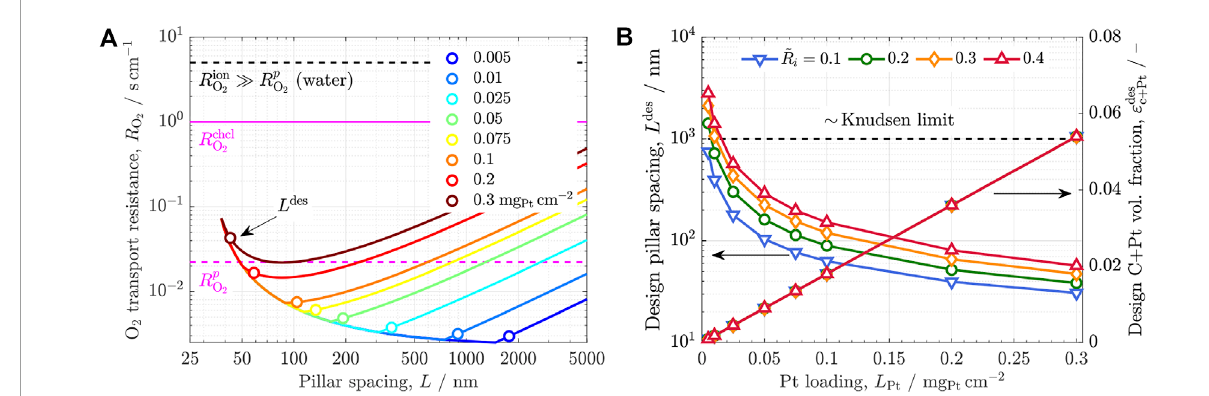
FIGURE 7 (A) Variation of the bulk O 2 transport resistance of the bi-functionalized bimodal cathode CL, R cl O , with the pillar spacing, L , corresponding to 2 various Pt loadings, L Pt = 0 . 005 , 0 . 01 , 0 . 025 , 0 . 05 , 0 . 075 , 0 . 1 , 0 . 2 , 0 . 3 mg Pt cm −2 , and ̃ R i = 0 . 25. The figure also includes the O 2 transport resistance in optimized water-filled nanopores, R p O = L p / D eff O ≈ 0 . 02 s cm −1 , the channel-CL O 2 transport resistance of state-of-the-art PEMFCs 2 2 , p ∼ 1 s cm −1 , and the local O 2 transport resistance reported for non-optimized conventional CLs (Owejan et al., 2013, 2014; Sun et al., 2020), R chcl O 2 ∼ 4 . 7 s cm −1 ≫ R p O with ionomer thin films covering Pt nanoparticles at r f ≈ 1 (Sánchez-Ramos et al., 2021), R ion O (water). The design spacing is 2 , p 2 Π = 1 . 2 ) , close to the optimal point of minimum bulk and local transport resistances. (B) Variation of the design spacing, selected for δ cl = Π δ min cl ( L des , and the design volume fraction of electron-conductive material + Pt, ɛ c+Pt , Pt loading, L Pt , corresponding to ̃ R i = 0 . 1 , 0 . 2 , 0 . 3 , 0 . 4. The Knudsen limit for which species diffusion is not significantly reduced is around 1000 nm.